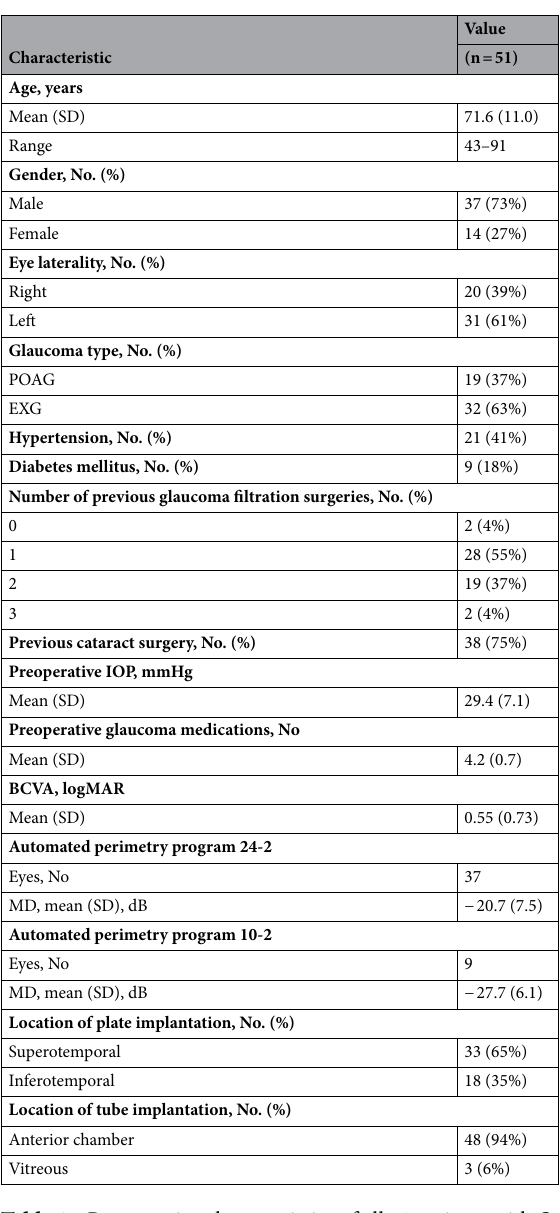
Table 1. Preoperative characteristics of all 51 patients with OAG. OAG open-angle glaucoma, SD standard deviation, POAG primary open-angle glaucoma, EXG exfoliation glaucoma, IOP intraocular pressure,